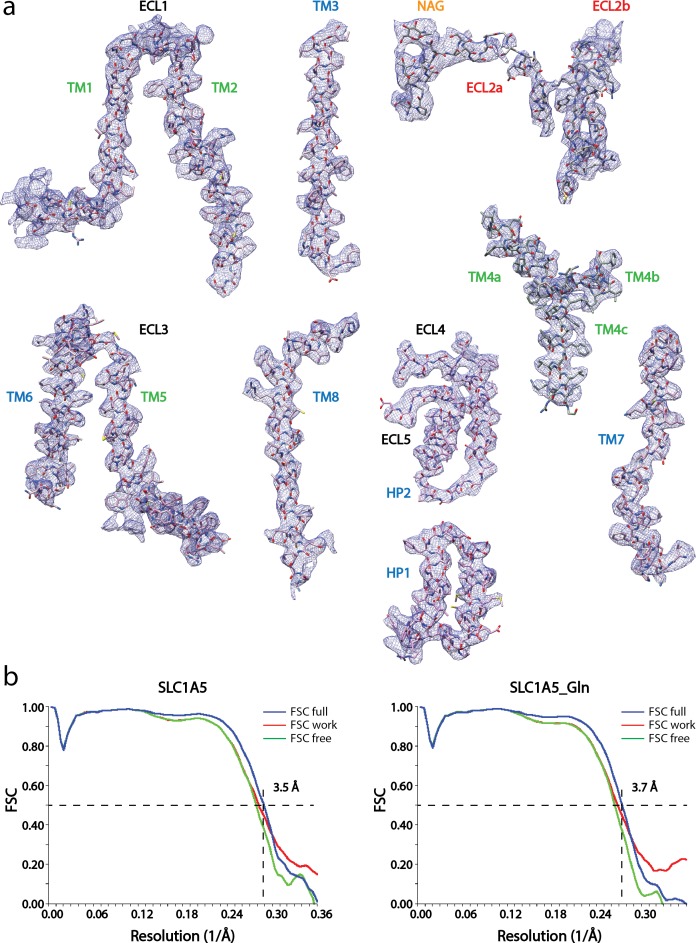
Cryo-EM densities of the eight transmembrane helices with ECL loops of SLC1A5-cKM4012 (Fab).(a) Cryo-EM density is sharpened with a negative b-factor 15 Å2 and displayed at the contour level 8σ for the transmembrane helixes and loops regions, except for the ECL2a, and b regions at 5.6σ and 4σ respectively. The atomic model with side chains are shown as sticks. The segments are labeled and colored as in Figure 1c. (b) Model validation. Comparison of the FSC curves between model and half map 1 (work), model and half map 2 (free), and model and full map are plotted in red, green and blue, respectively.